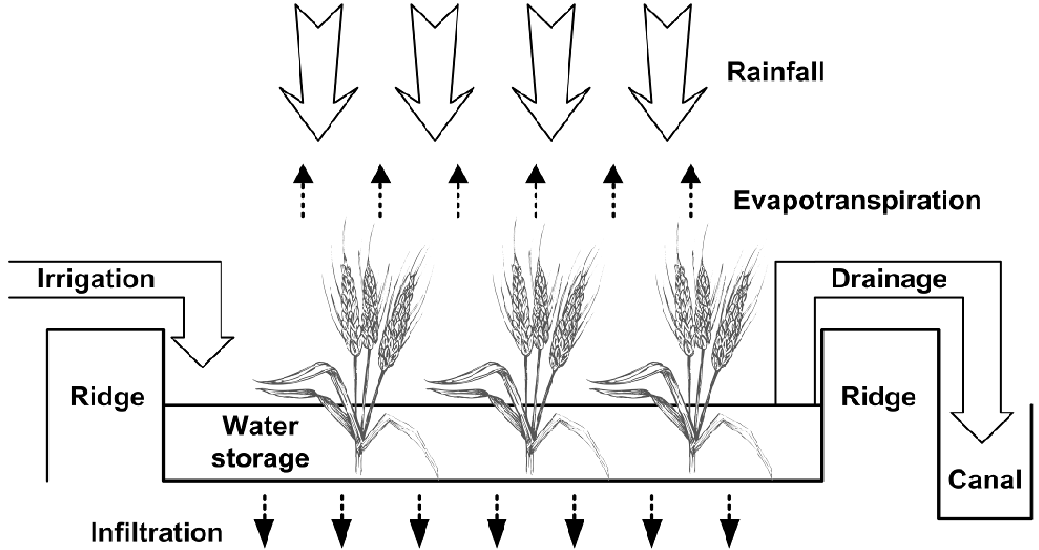
Figure 5. Concept of water balance in paddy